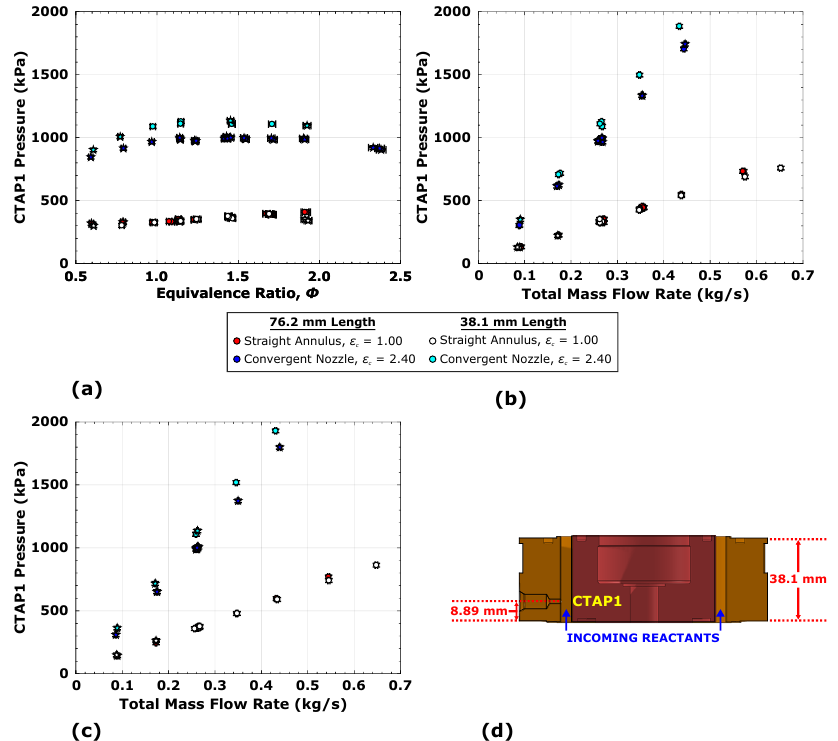
Figure 16. Equivalent average pressure measured at CTAP1 for the ( a ) equivalence ratio conditions and mass flow rate conditions at ( b ) φ = 1.15 and ( c ) φ = 1.5, as well as the ( d ) location of the measurement sites for the reduced length geometry. Depending on the flow condition and convergent nozzle geometry, the engine operates in either a corotating ( • ) or counter-propagating mode ( (cid:63) ).